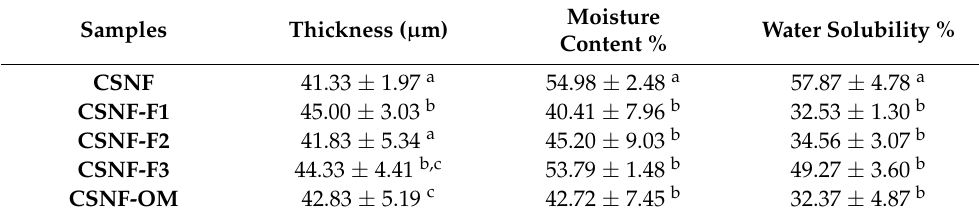
Figure 1. The general appearance of the films. ( A ) CSNF; ( B ) CSNF-F1; ( C ) CSNF-F2; ( D ) CSNF-F3; ( E ) CSNF-OM. Table 2. Thickness, moisture content and water solubility of the nanocomposite